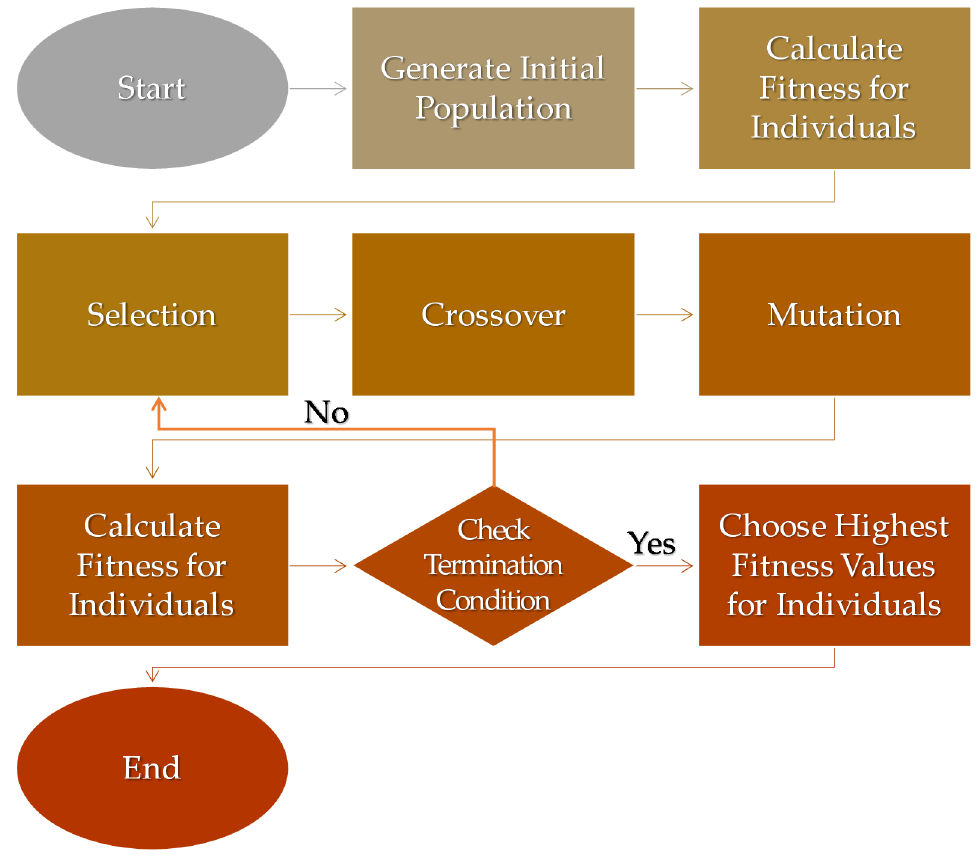
Figure 3. The process of a genetic algorithm.